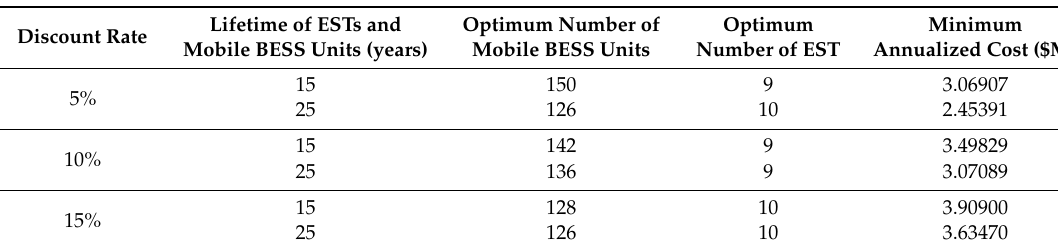
Table 1. Summary table of the optimization results under varying discount rates and project’s lifetime.